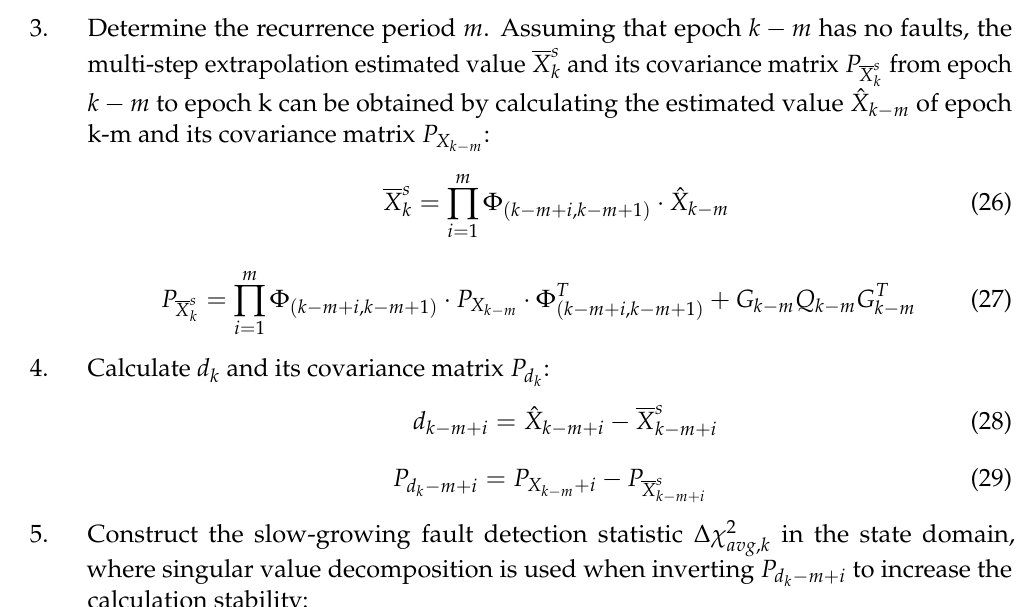
5. Construct the slow-growing fault detection statistic ∆ χ 2 where singular value decomposition is used when inverting P d calculation stability: